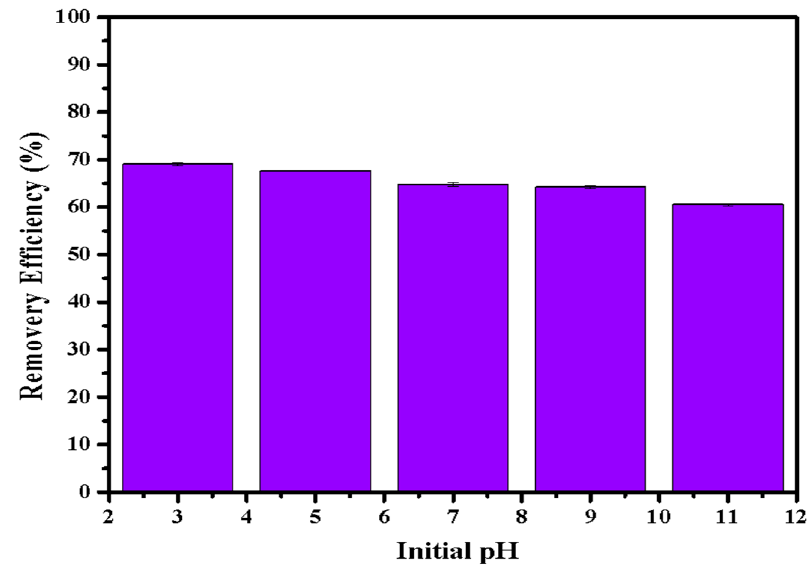
Figure 6. Effect of pH on phosphate removal efficiency.